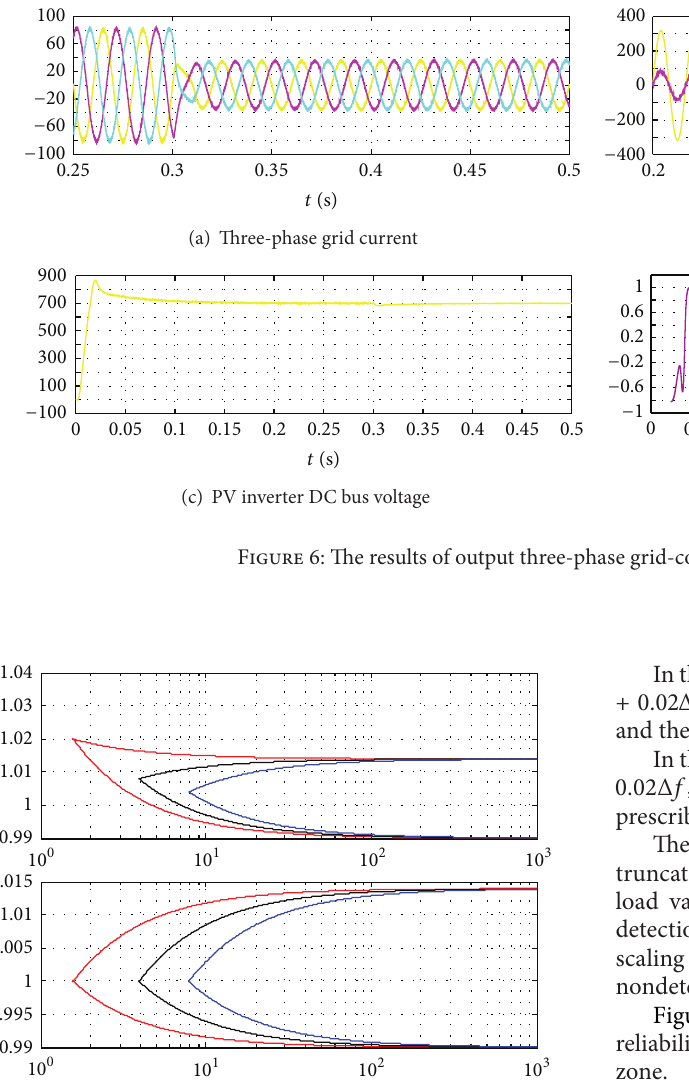
Figure 7: The nondetection zone of AFDPF.